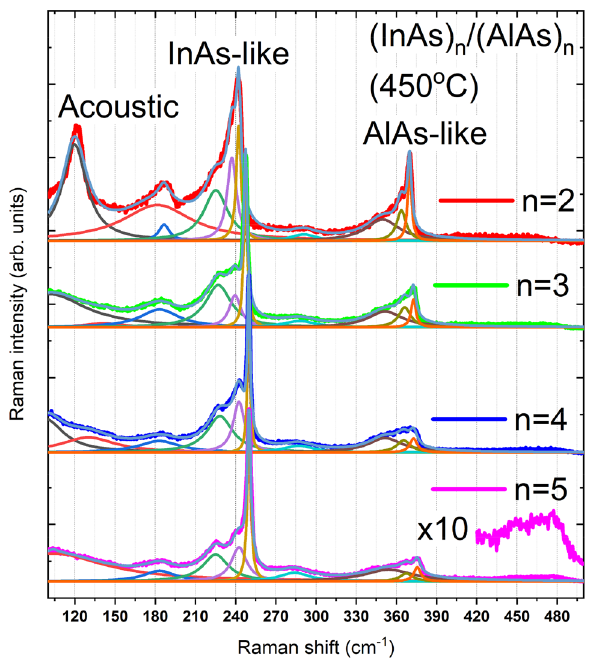
Figure 2. Raman spectra of InAlAs RA and (InAs) n /(AlAs) n SPSs with n = 2, 3, 4, and 5 grown at 450 °C. The InAs-like, AlAs-like, and acoustic phonon regions are marked. Fitting results by Lorentz profile are shown. Three peaks are resolved in both InAs- and AlAs-like regions, respectively. The enlarged portion (X10) around 480 cm −1 for the n = 5 sample exhibits the second-order phonon